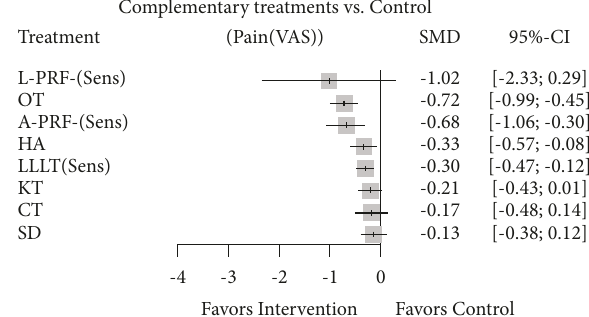
Figure 9: Forest plot comparing different complementary inter- ventions for reducing early pain after third molar surgery. PRF: platelet-rich fibrin; SD: surgical drainage; CT: cryotherapy; HA: hyaluronic acid; KT: Kinesio taping; LLLT: low-level laser therapy; OT: ozone therapy; Plc: placebo.